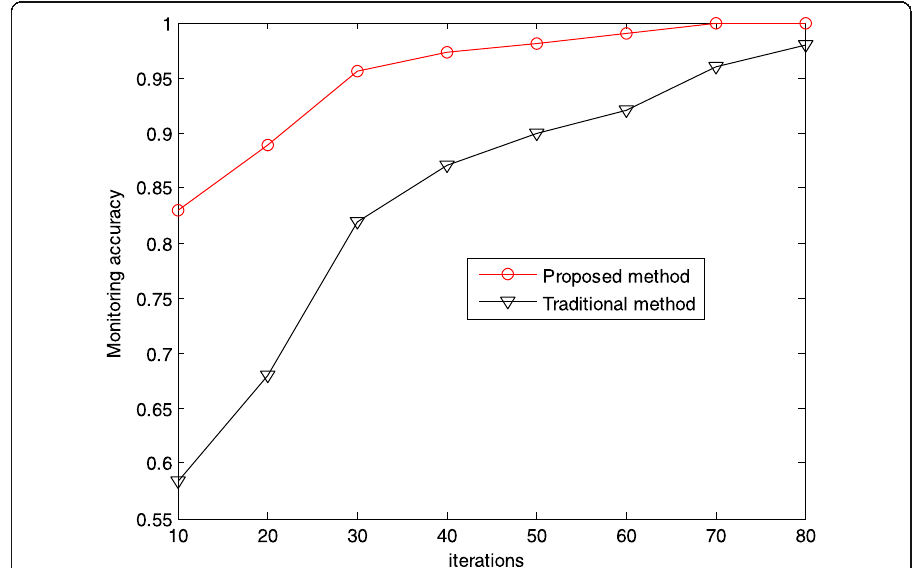
Fig. 6 Influence of communication radius on DV-HOP location